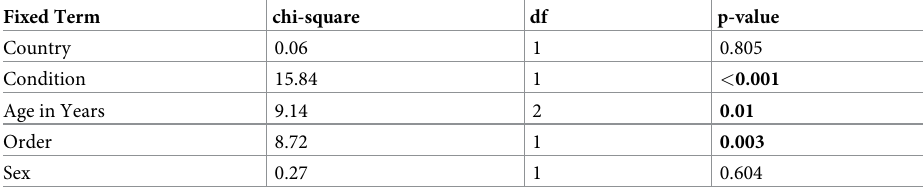
Table 1. Generalized linear mixed models for Experiment